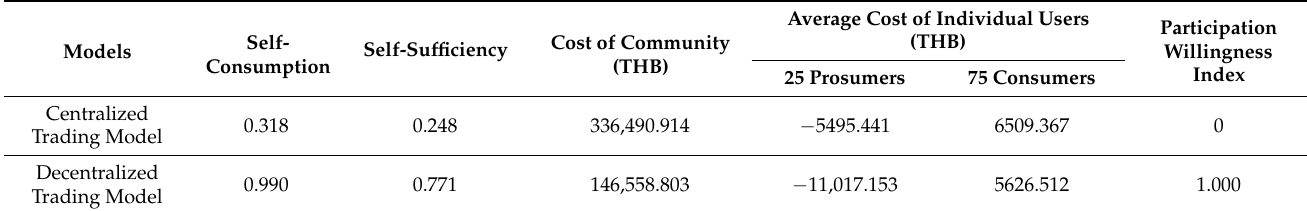
Table 1. Model assessment at community level and individual